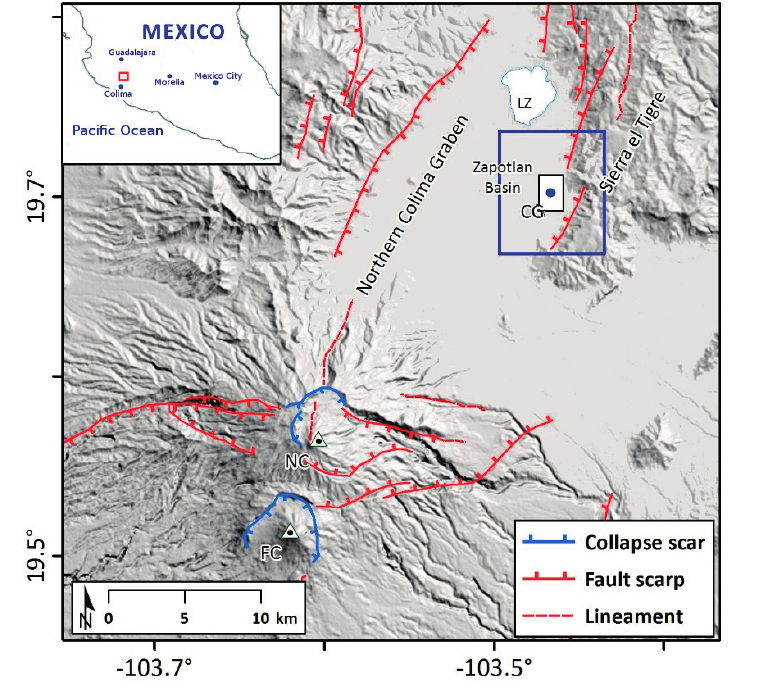
Figure 1. Main tectonic and volcanotectonic structures in the Northern Colima Graben (NCG). The red box in the upper left panel locates the Colima and CG area, the blue box in the main panel locates Figure 2 while the white box locate Figure 3. CG: Ciudad Guzmán, NC: Nevado de Colima volcano, FC: Fuego de Colima volcano, LZ: Laguna Zapoltlan (modified from